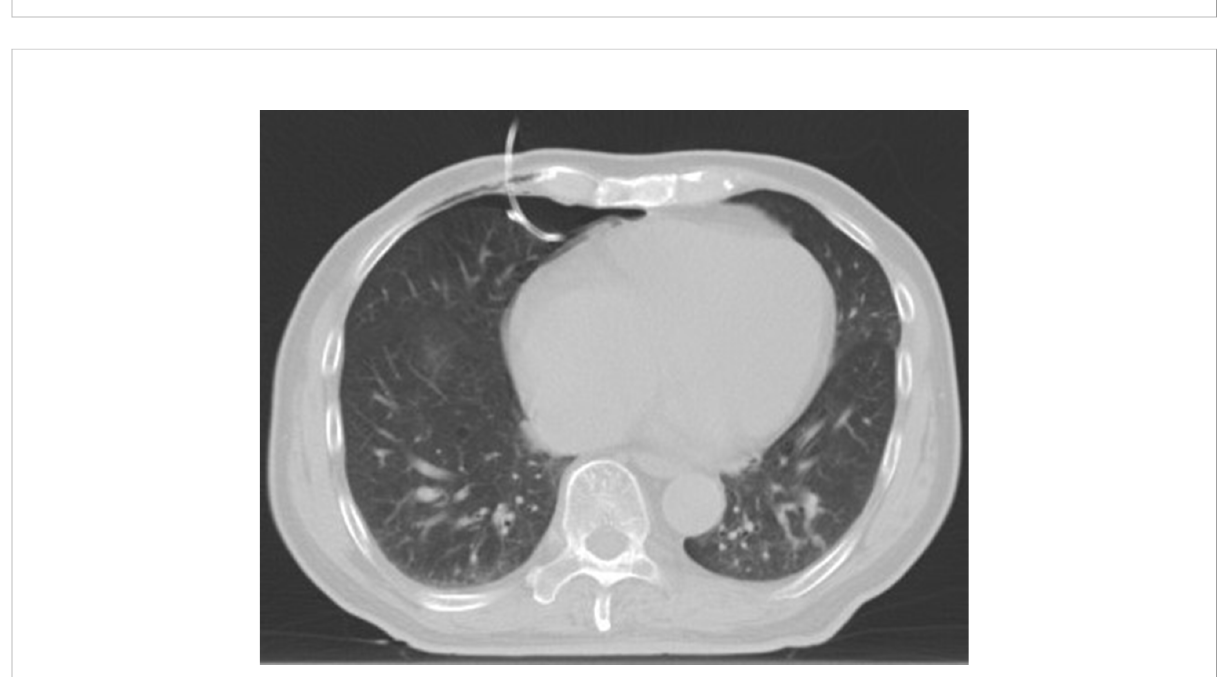
FIGURE 4 The arti fi cial hydrothorax was created: Following the establishment of the arti fi cial pneumothorax, the guide wire was inserted after the puncture needle gradually reached the pleural cavity containing the arti fi cial pneumothorax, and an 8F central venous catheter was indwelled along the guide